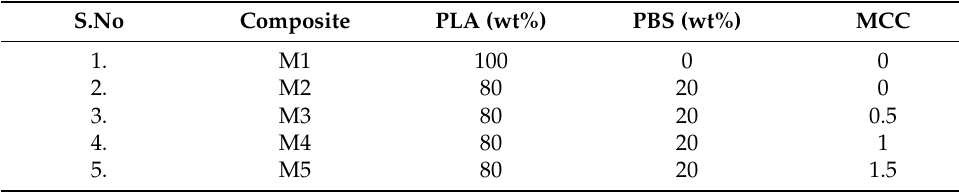
Table 1. Composition of PLA/PBS/MCC Composites